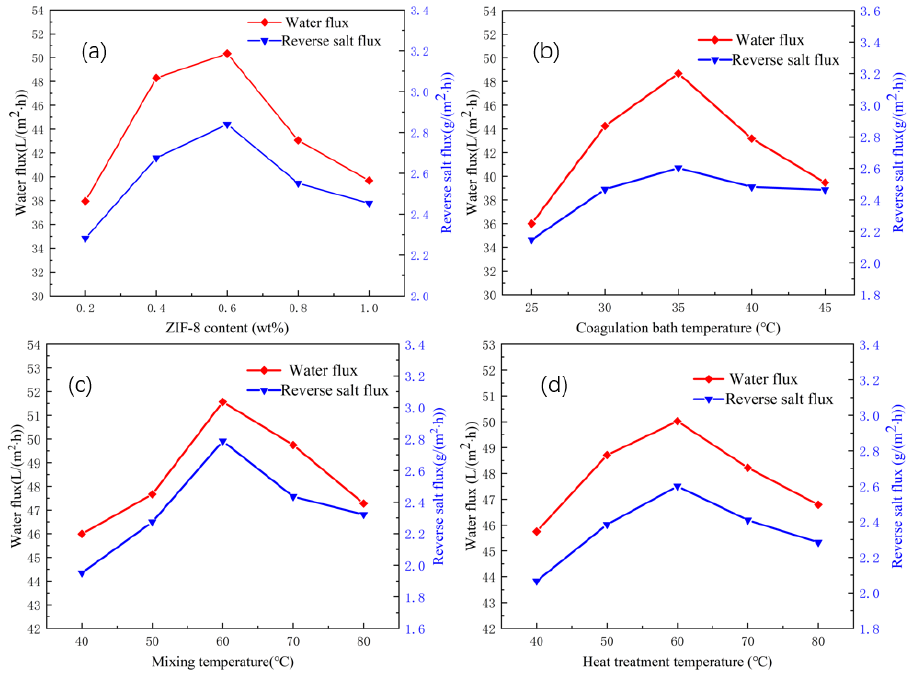
Figure 7. Influence of ZIF-8 content ( a ); coagulation bath temperature: 35 °C, mixing temperature: 60 °C, heat treatment temperature: 60 °C, coagulation bath temperature ( b ); ZIF-8 content: 0.4 wt%, ture: 60 ◦ C, heat treatment temperature: 60 ◦ C, coagulation bath temperature ( b ); ZIF-8 content: mixing temperature: 60 °C, heat temperature: 60 °C mixing temperature ( c ); ZIF-8 content: 0.4 wt%, 0.4 wt%, mixing temperature: 60 ◦ C, heat temperature: 60 ◦ C mixing temperature ( c ); ZIF-8 con- mixing temperature: 60 °C, heat treatment temperature: 60 °C and heat treatment temperature ( d ); tent: 0.4 wt%, mixing temperature: 60 ◦ C, heat treatment temperature: 60 ◦ C and heat treatment ZIF-8 content: 0.4 wt%, mixing temperature: 60 °C, coagulation bath temperature: 35 °C on CA/ZIF- temperature ( d ); ZIF-8 content: 0.4 wt%, mixing temperature: 60 ◦ C, coagulation bath 8 membrane.